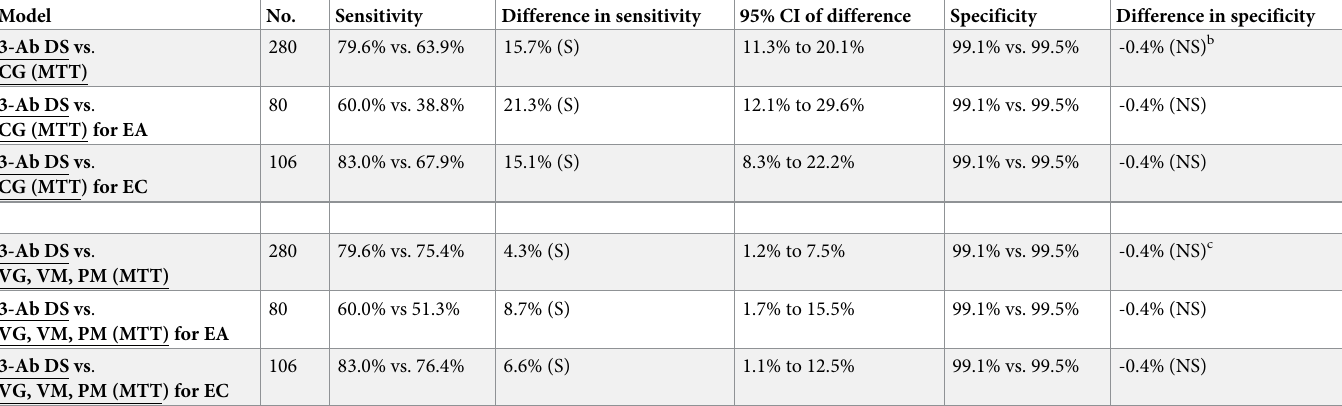
Table 7. Sensitivity of the 3-antibody diagnostic score versus MTT binary models at equivalent specificity a . Model